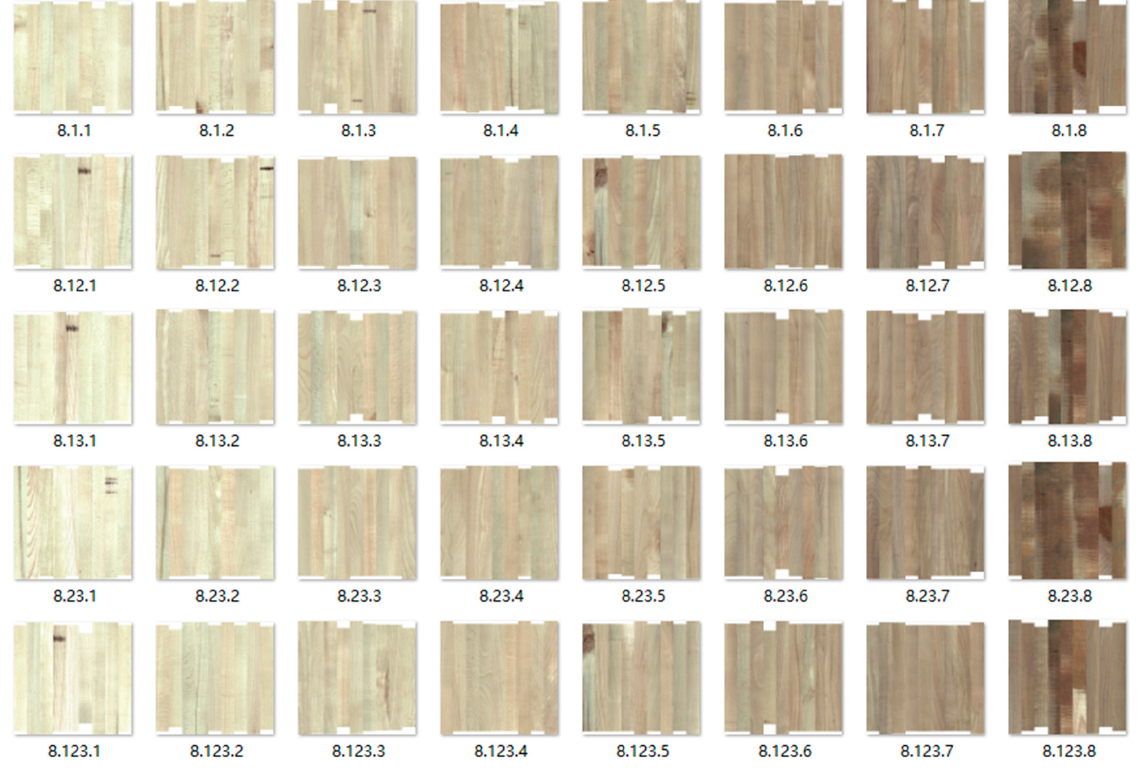
Figure 7. K = 8 clustering result images.